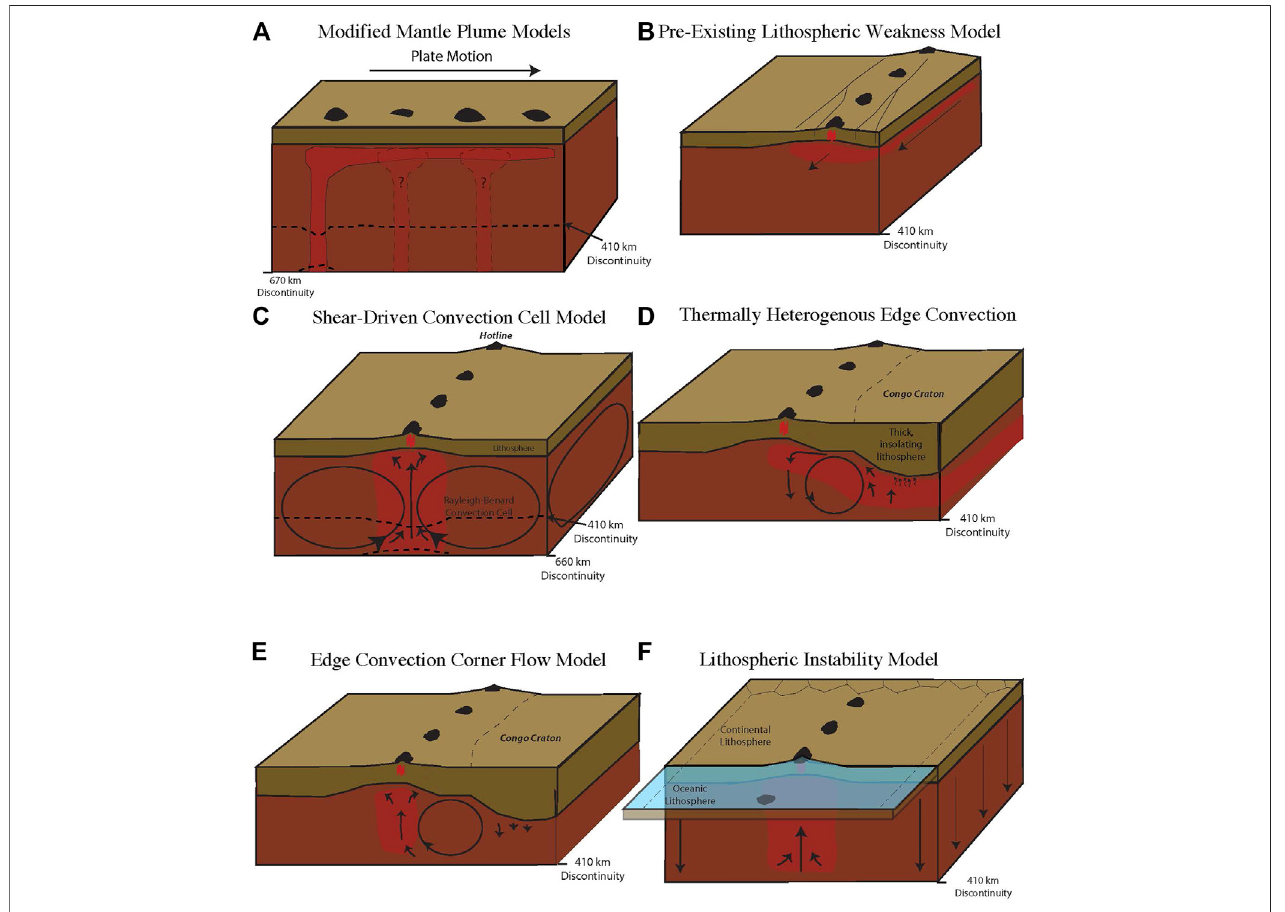
FIGURE 9 | Geodynamic models for the formation of the CVL, included modi fi cations of mantle plume trace (A) , diversion of material along the CASZ (B) , convection driven by shear along the base of the transition zone (C) , convection driven by thermal contrasts combined with contrasts in lithospheric thickness (D) , convection driven by contrasts in lithospheric thickness in a thermally homogenous mantle (E) , and lithospheric instabilities driven by the juxtaposition of oceanic and continental lithosphere (F) after Adams et al. (2015).